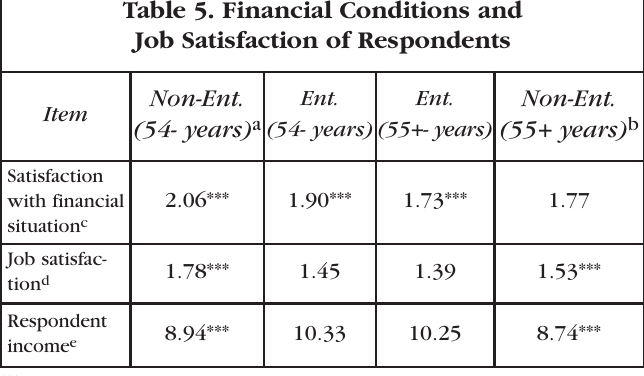
Table 5. Financial Conditions